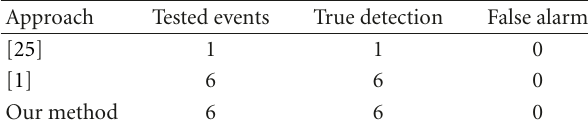
Table 3: Comparison of PETS2006 dataset.